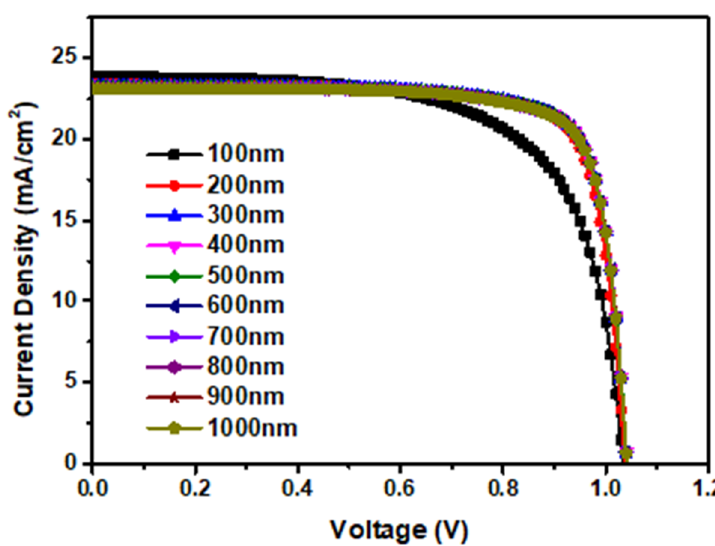
Figure 3. Current density–voltage ( J– V) curves for various ZnO thicknesses.